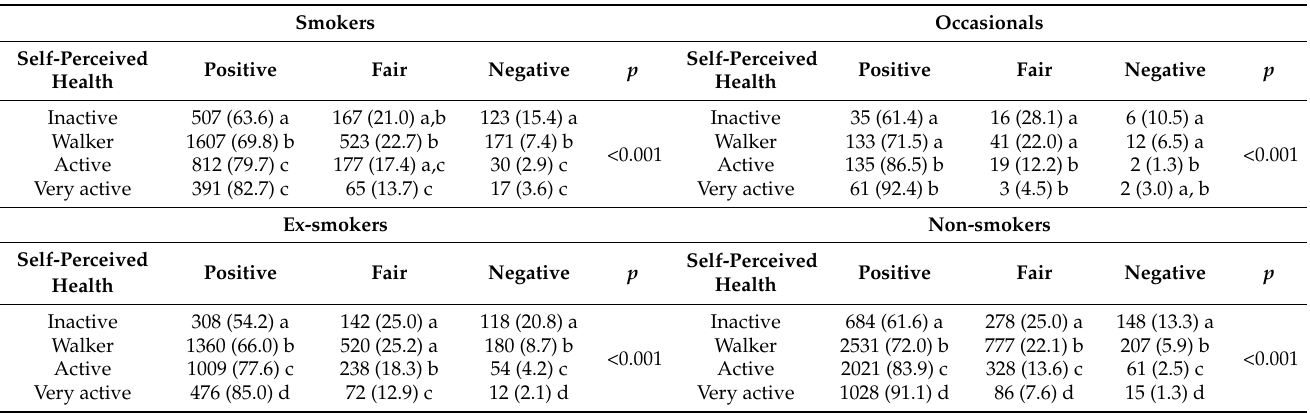
Table 3. Relationships between level of physical activity and self-perceived health, according to the relationship with smoking in the Spanish population of the ENSE